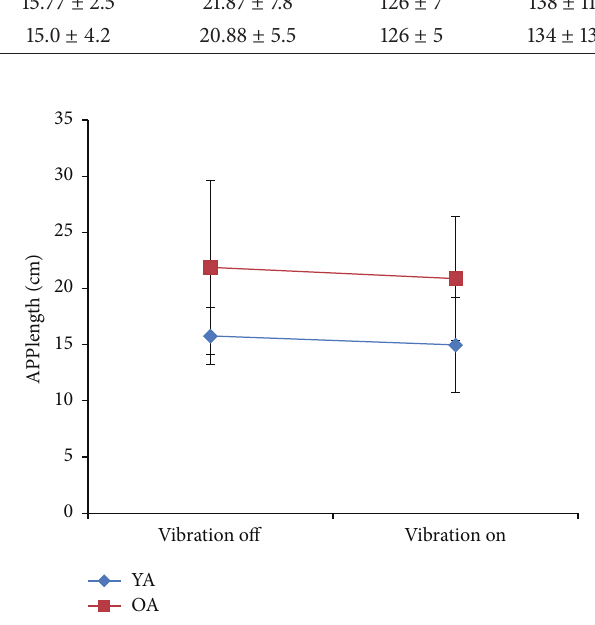
Figure 3: Comparison of APPlength in postural perturbation task between older adults (OA) and younger adults (YA).